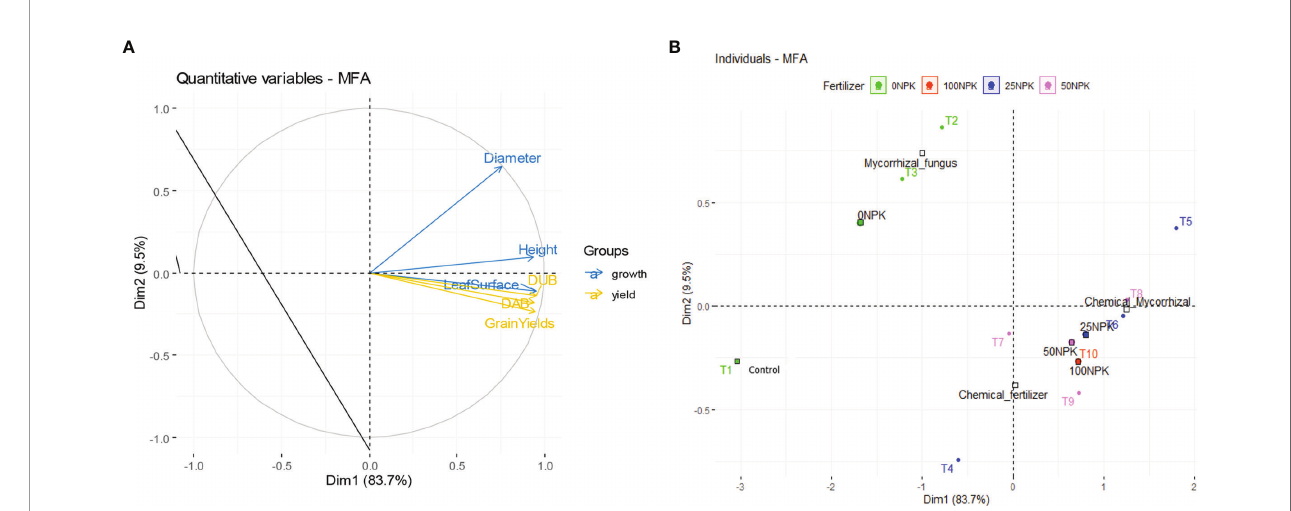
FIGURE 4 | Projections of variables (A) and treatments (B) in the fi rst two dimensions of the Multiple Factor Analysis